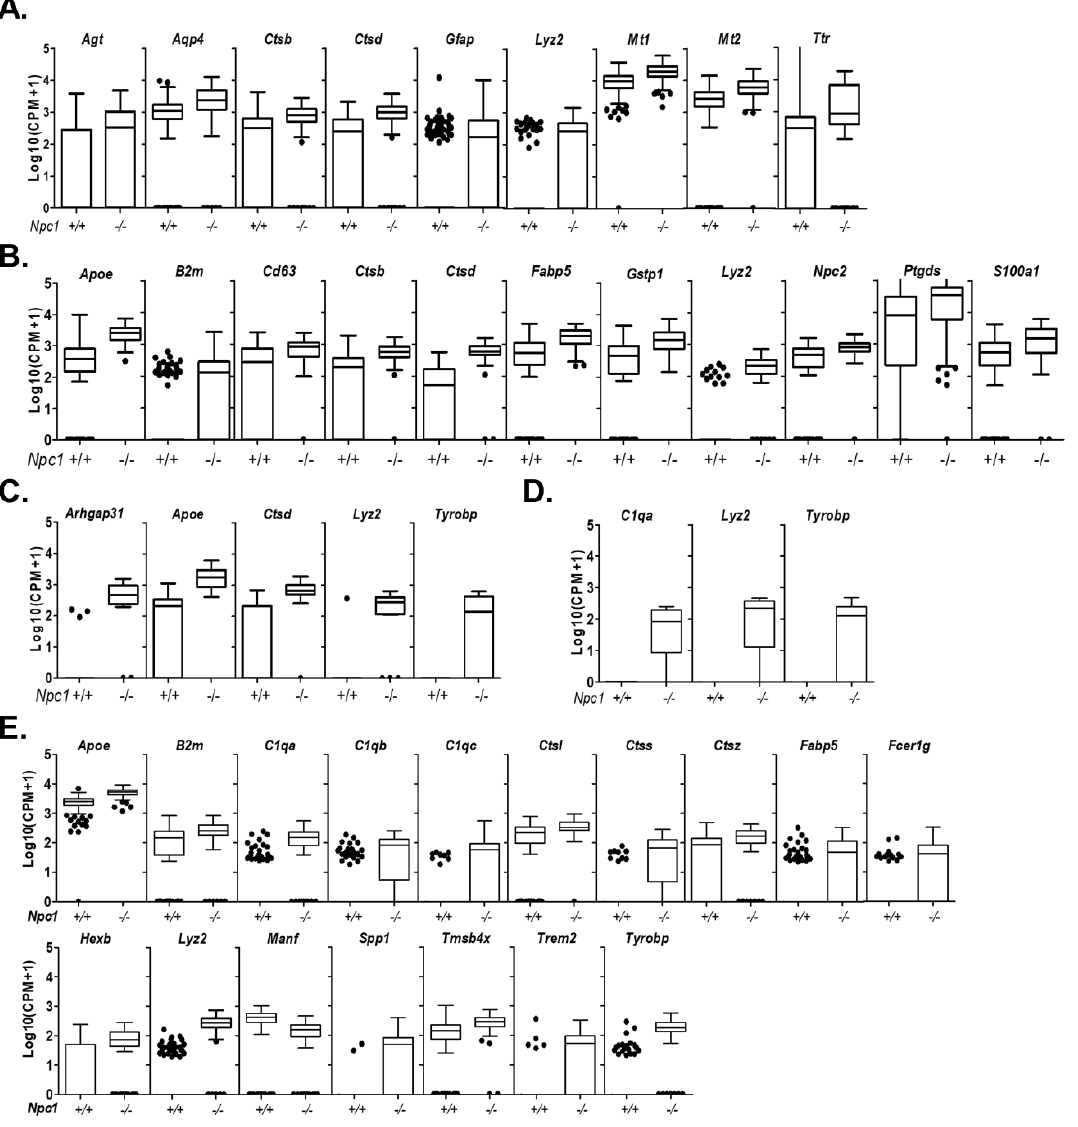
Figure 4. Di ff erentially expressed genes in glial cells. Tukey box plot of di ff erentially expressed genes in Figure 4. Differentially expressed genes in glial cells. Tukey box plot of differentially expressed genes astrocytes ( A ), oligodendrocyte precursors ( B ), di ff erentiated oligodendrocytes ( C ), ependymal ciliated in astrocytes ( A ), oligodendrocyte precursors ( B ), differentiated oligodendrocytes ( C ), ependymal ( D ), and ependymal secretory cells ( E ) between ciliated ( D ), and ependymal secretory cells ( E ) between genotype.